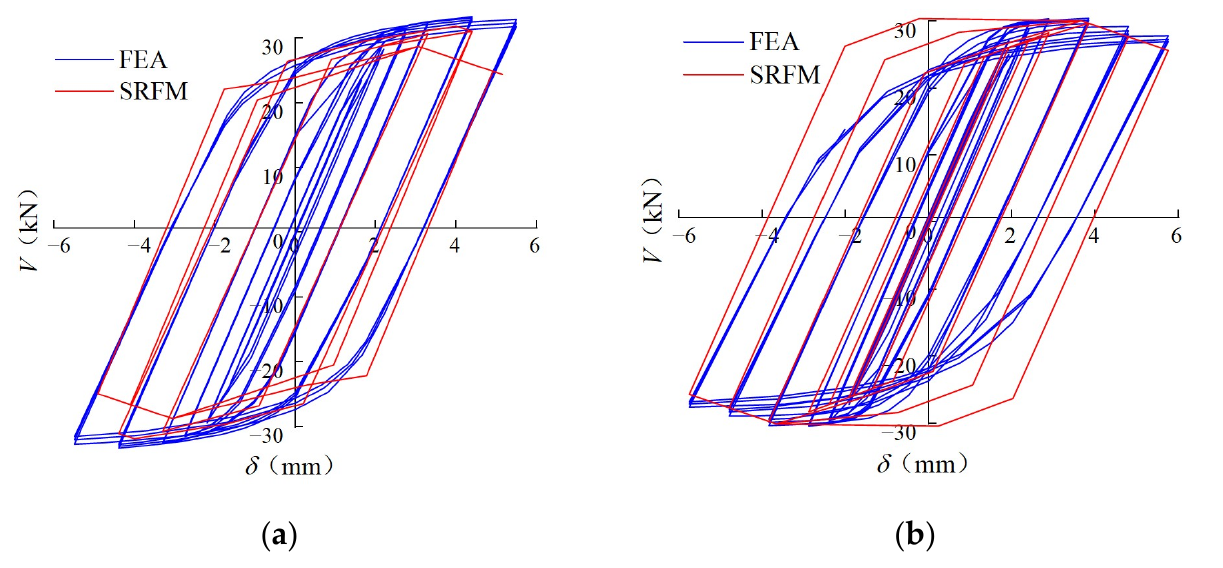
Figure 27. The comparison on the hysteresis curves between FEA model and SRFM for members failed with strength. ( a ) C1-BC-L15-40-02. ( b ) C1-BC-L15-40-03. 2. The comparison on the hysteresis curves between the proposed SRFM and the FEA model for CFTWS lipped channel members failed with global buckling is shown in Figure